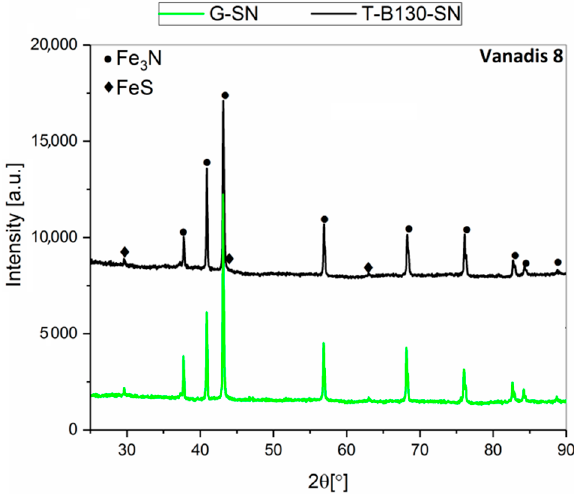
Figure 7. X-ray diffraction spectra recorded in the SL of Vanadis 8 tool steel after: G-SN and T-B130-SN.